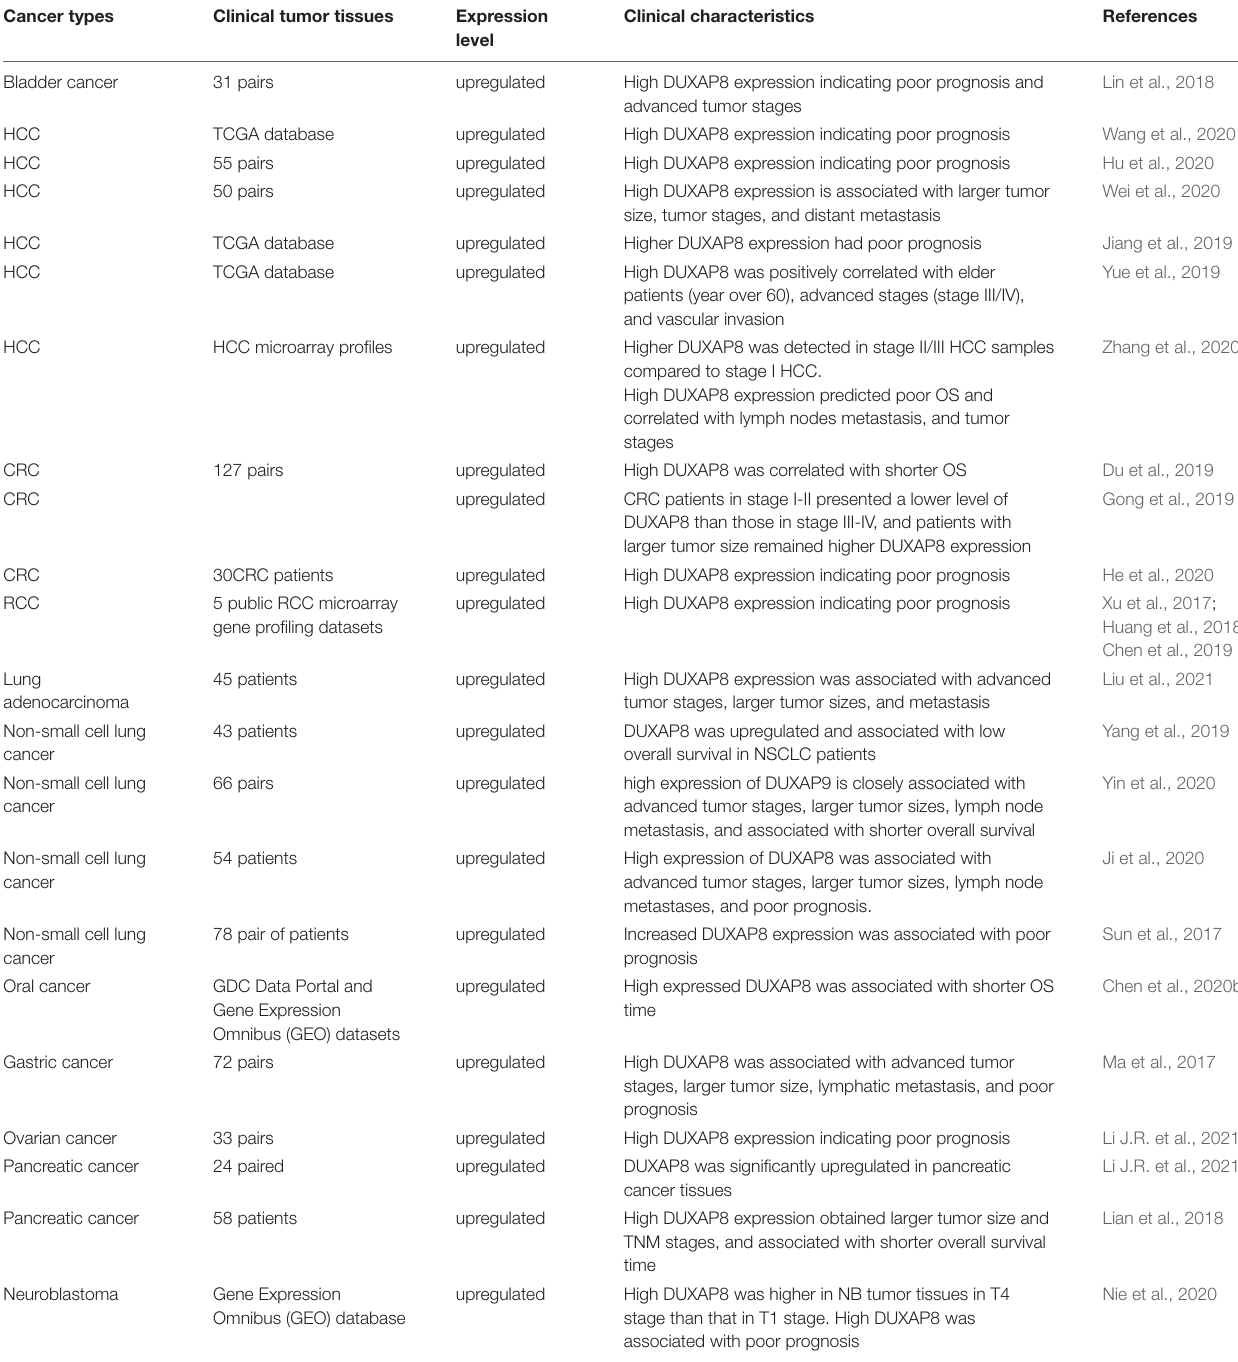
TABLE 1 | The clinical information of double homeobox A pseudogene 8 (DUXAP8) in